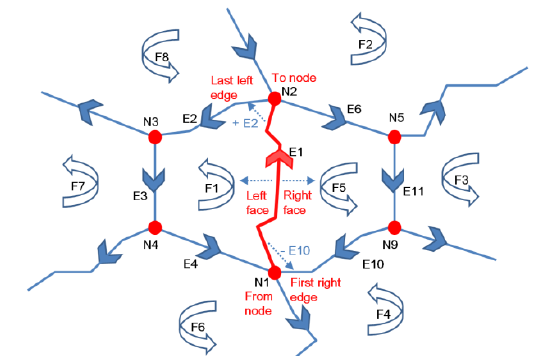
Figure 1. 2D topology model as used in the Malaysian country